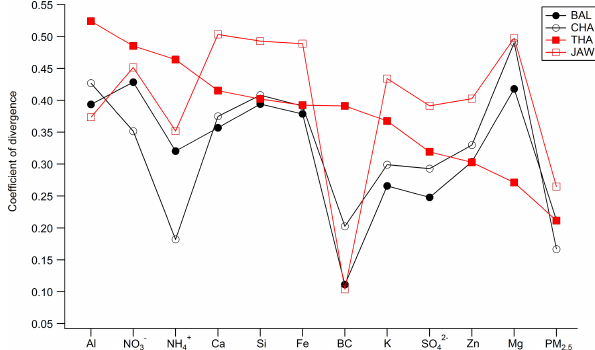
Figure 10. Mean coefficient of divergence (COD) for 24h average concentrations of PM 2 . 5 , BC, and PM 2 . 5 chemical constituents at four sites during